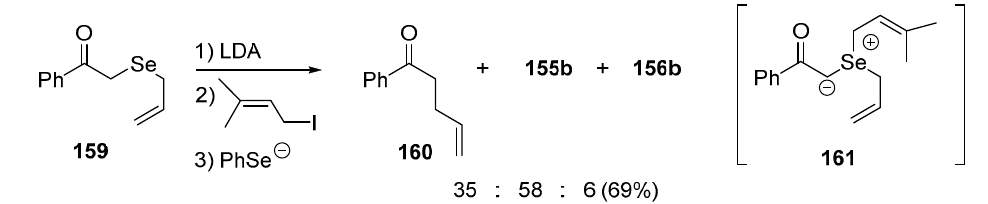
Figure 16. Enolate 157 and ylide 158 .